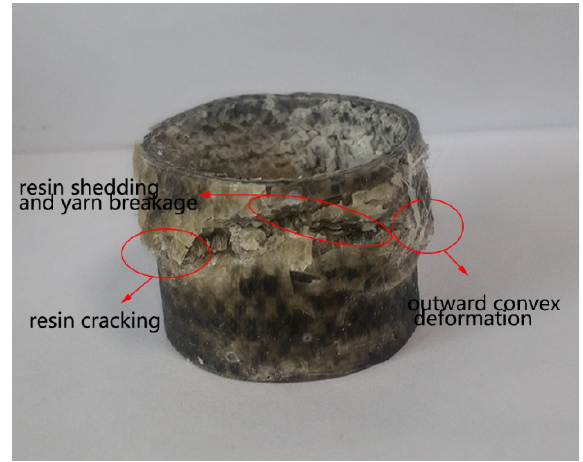
Figure 6. Final failure photograph of the 3D tubular woven composite.